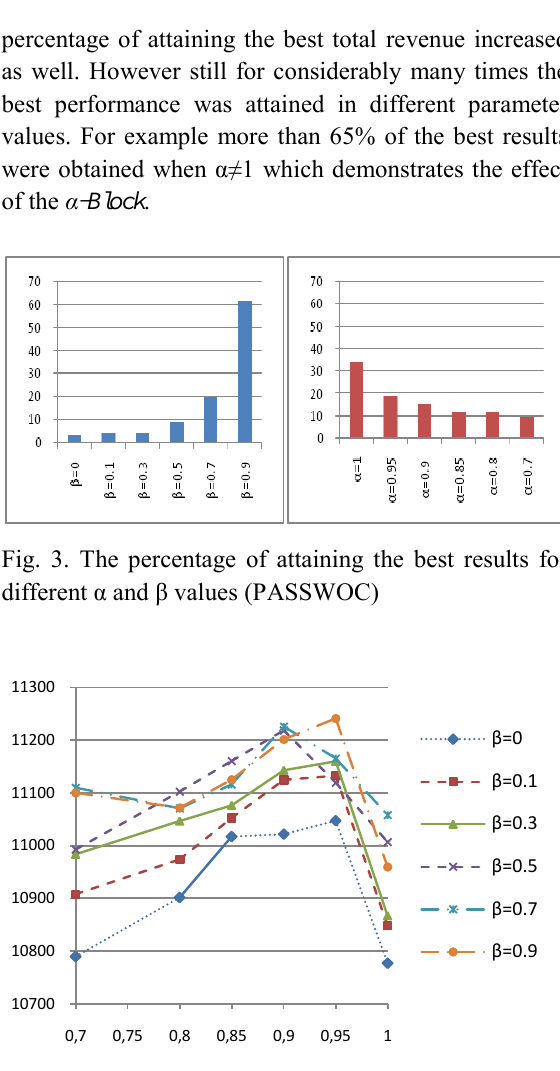
Fig. 4. The performance of the algorithm for different α and β values (A =2, B=1 and N=100). The vertical axis is the revenue and the horizontal axis is α values.